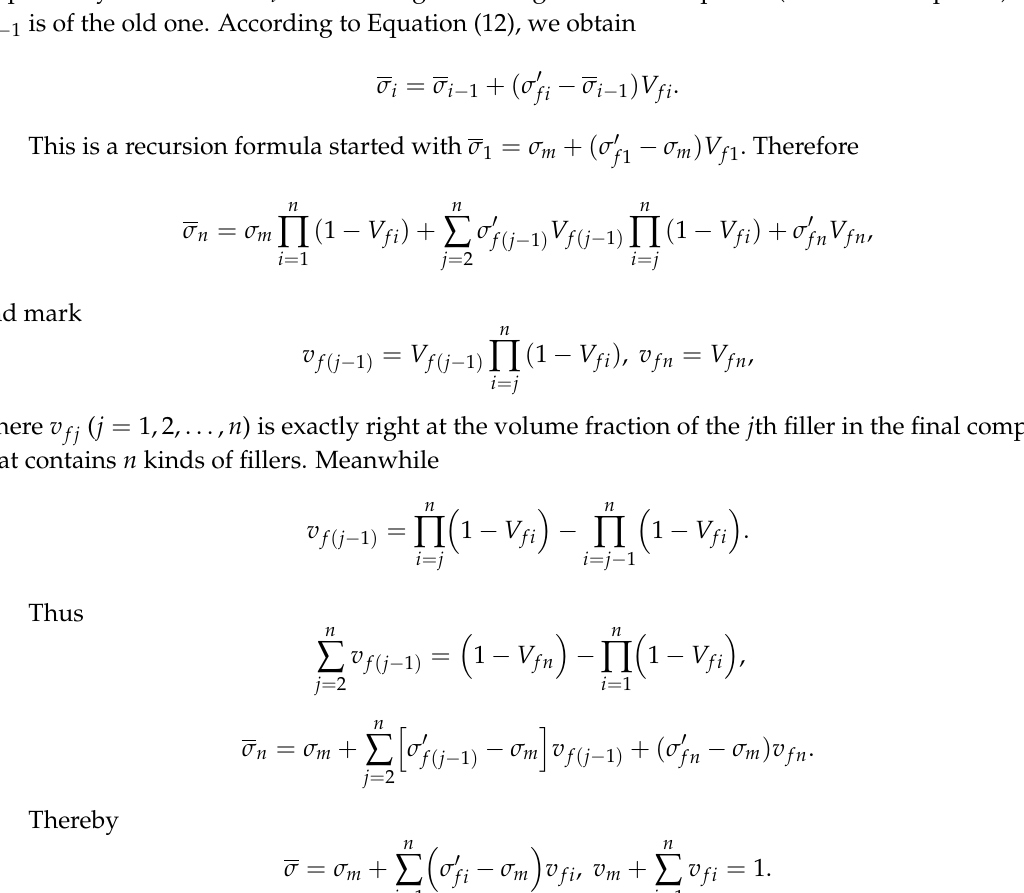
Figure A3. The maximum strength and elongation at break in uniaxial tension.